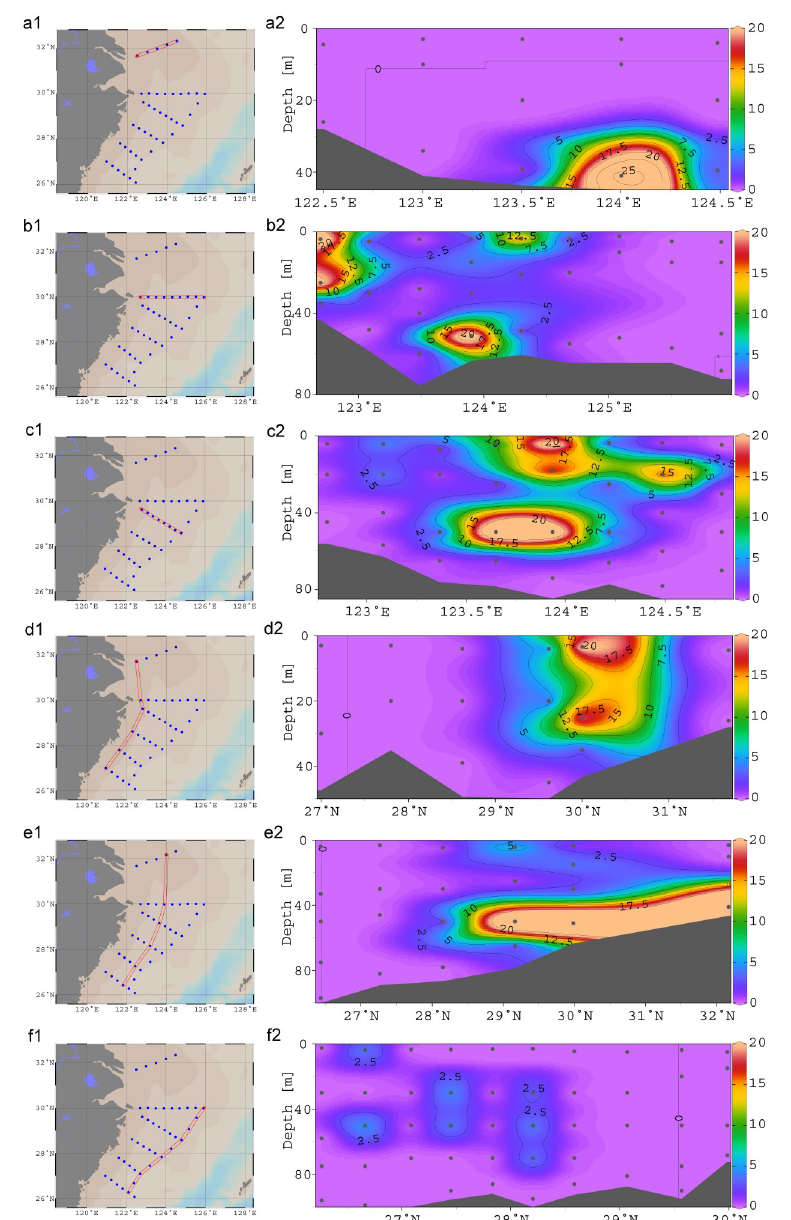
Fig 3. Vertical distributions of small yellow croaker along different longitude and latitude sections in the East China Sea. The x-axis and y-axis represent longitude and water depth, respectively, in a-c, whereas the x-axis and y- axis are latitude and water depth in d-f. Black dots denote sampling stations. The eDNA concentrations (logarithm transformed) are shown with gradient colors. A significant difference was found among three water layers of L . polyactis (chi-squared = 6.0571, df = 2, p = 0.04839 <